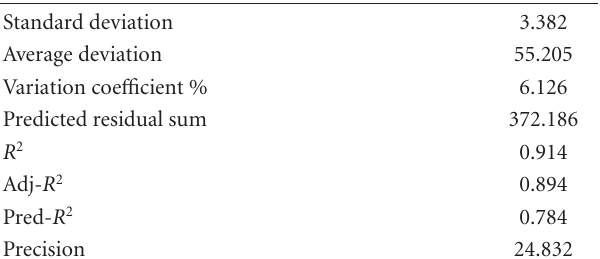
Table 6: Variance analysis (ANOVA) of the model 2FI (partial sum of squares, type